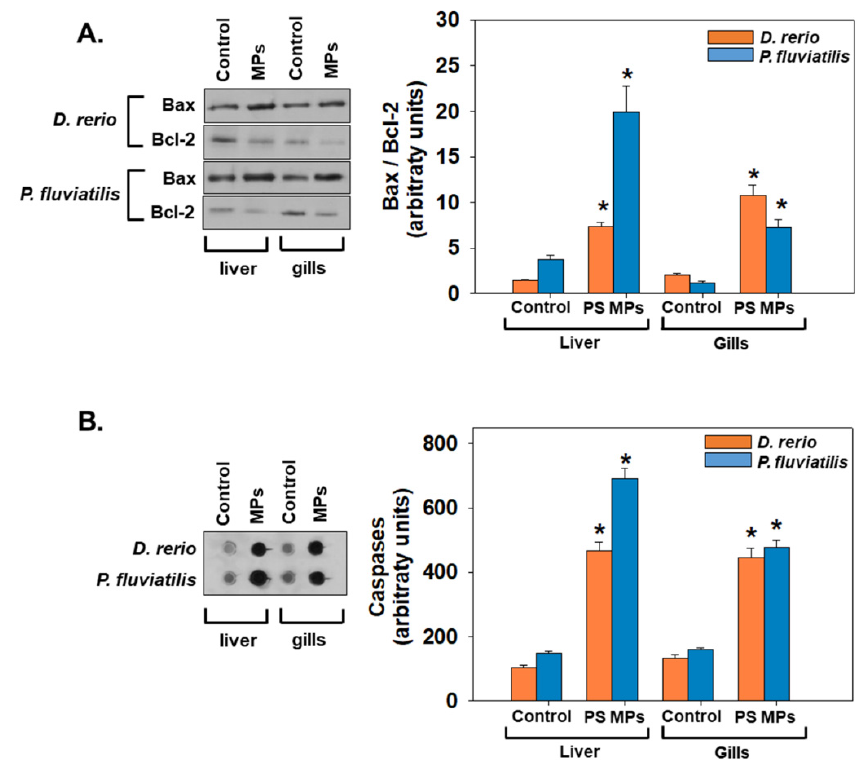
Figure 7. Bax/Bcl-2 ratio ( A ) and caspases levels ( B ) (mean ± SD) in liver and gills of Danio rerio ( n = 3 pools of 10 individuals each pool) and Perca fluviatilis ( n = 6). Tissue extracts from all groups were immunoblotted for Bax, Bcl-2 and caspases. Blots and dots were quantified using scanning densitometry. Representative blots and dots are shown. Mann–Whitney U test was employed to test for significance at p < 0.05 between all experimental groups. * denotes significant differences ( p < 0.05) compared to the control group ( n = 3 pools of 10 individuals and n = 6 for D. rerio and P. fluviatilis respectively).